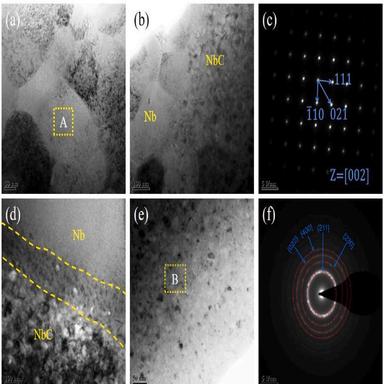
(a) Nb nanograins, (b) equiaxed NbC nanaograins around Nb nanograins, (c) SAED pattern of region A in (b) (calibrated as Nb phase), (d) equiaxed Nb2C nanograins with ribbon-like distribution, (e) high magnification of equiaxed Nb2C nanograins, (f) SAED pattern of region B in (e) (calibrated as Nb2C phase).